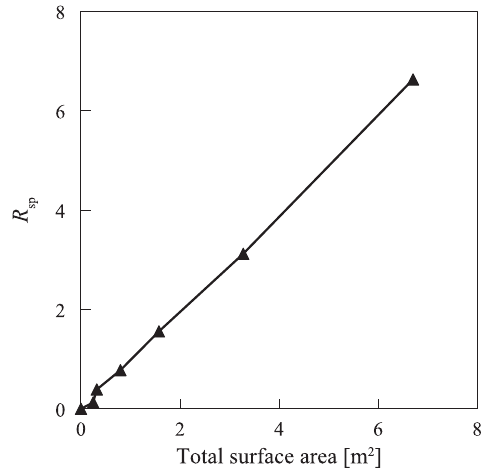
Fig. 5 Relaxation time constant as a function of number of ad- sorbed water layers calculated from water vapor ad- sorption isotherm.